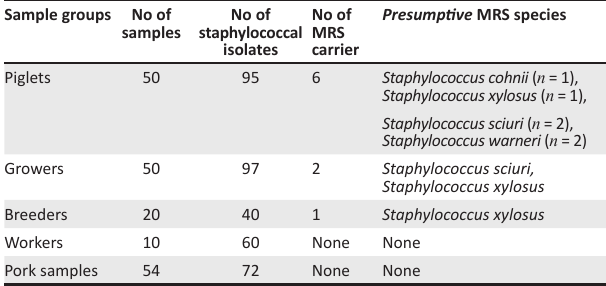
TABLE 2: Distribution of methicillin-resistant staphylococci among the sample groups. Sample groups No of samples